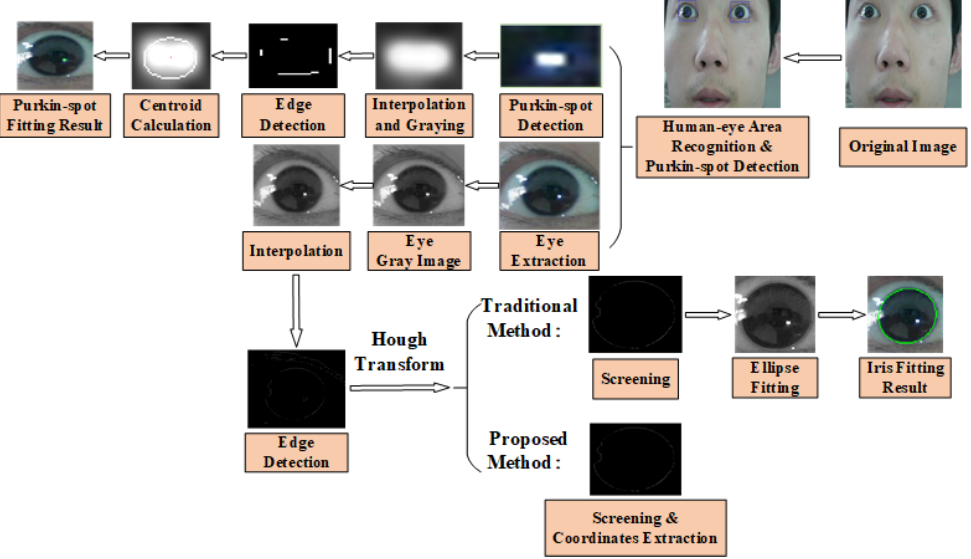
Figure 13. Iris detection and Purkin spot location.